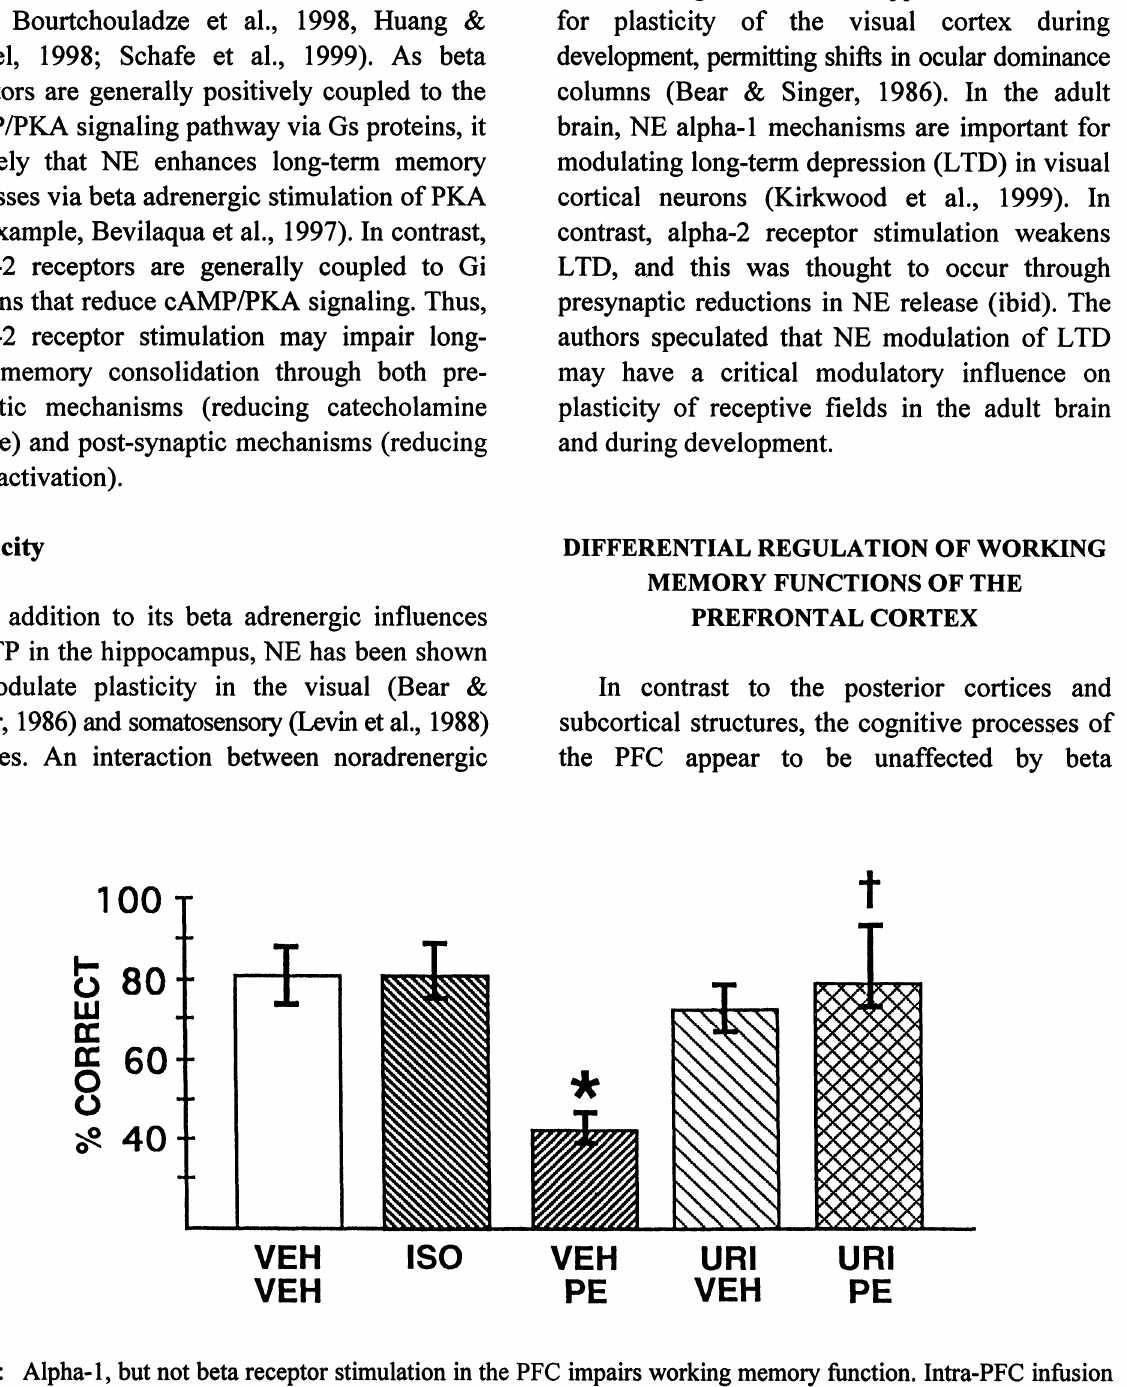
Fig. 2: Alpha-l, but not beta receptor stimulation in the PFC impairs working memory function. Intra-PFC infusion of the beta agonist, isoproterenol, has no effect on delayed alternation performance in rats. In contrast, intra- PFC infusion of the alpha-1 agonist, phenylephrine, induces working memory deficits that are reversed by co-infusion of the a6-16 antagonist, urapidil. Results represent mean+S.E.M, percent correct on the delayed alternation task. VEH vehicle; ISO isoproterenol (0.1 ugl0.5tl); PE phenylephrine (0.1tg/0.51al); URA urapidil (0.0 lg/0.5tl); *significantly different from vehicle + vehicle; *significantly different from phenylephrine + vehicle (adapted from Amsten et al.,